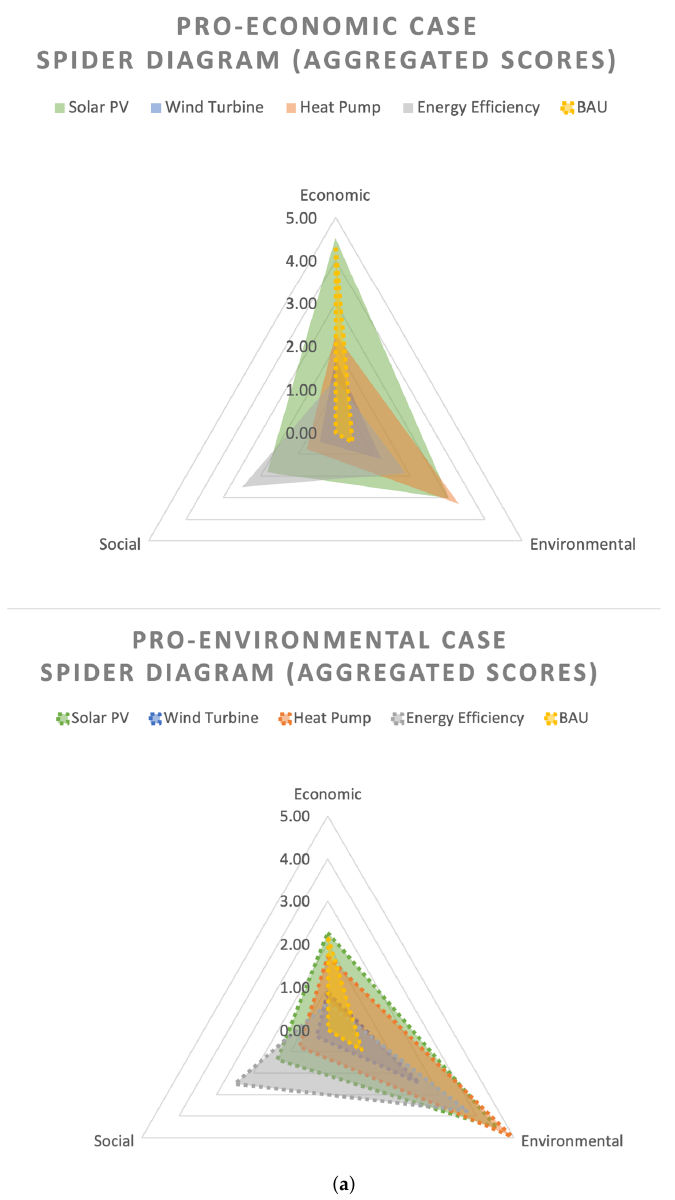
Figure 3. The scenario spider diagrams showing the aggregated scores. Table 9. The technology aggregated scores.